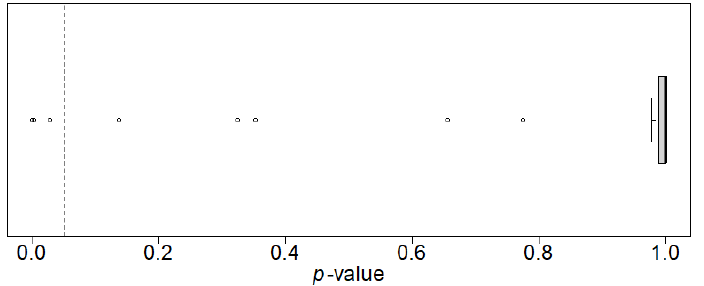
Figure 12. p -values of the Holm-corrected Fasano–Franceschini tests of the spatial distributions of